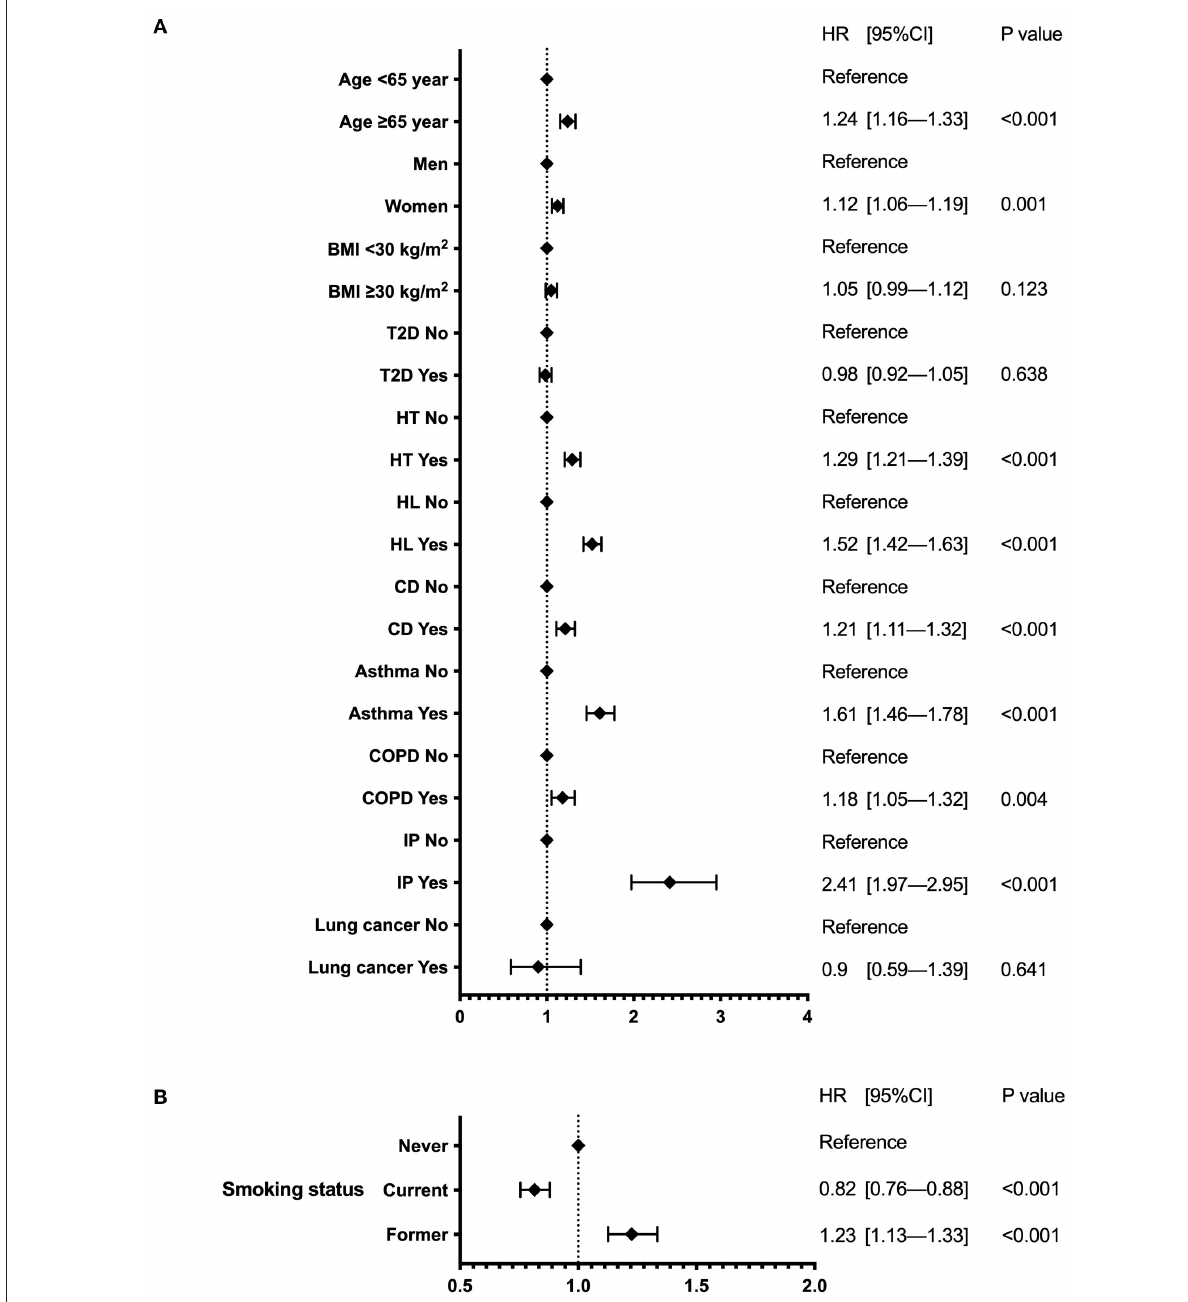
FIGURE2 Forest plot of reinfection risk. The forest plot indicates the hazard ratios (diamonds) and 95% confidence intervals (horizontal bars) for reinfection risk. (A) Patient background and underlying disease. (B) Smoking status. BMI, body mass index; CI, confidence interval; HR, hazard ratio; T2D, type 2 diabetes; HT, hypertension; HL, hyperlipidemia; CD, cardiovascular disease; COPD, chronic obstructive pulmonary disease; IP, interstitial